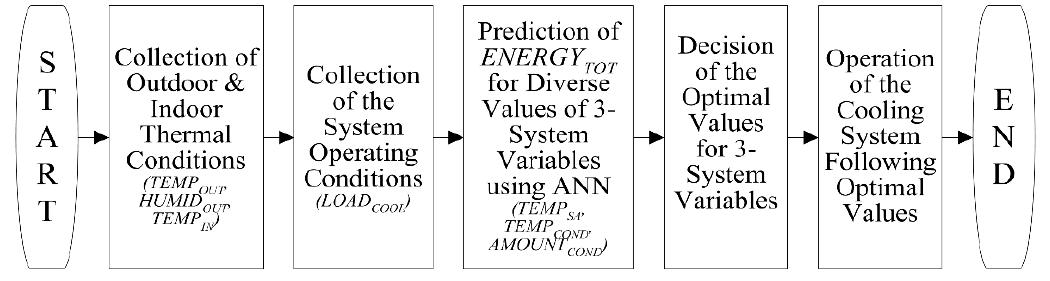
Figure 5. Flowchart of the control algorithm.